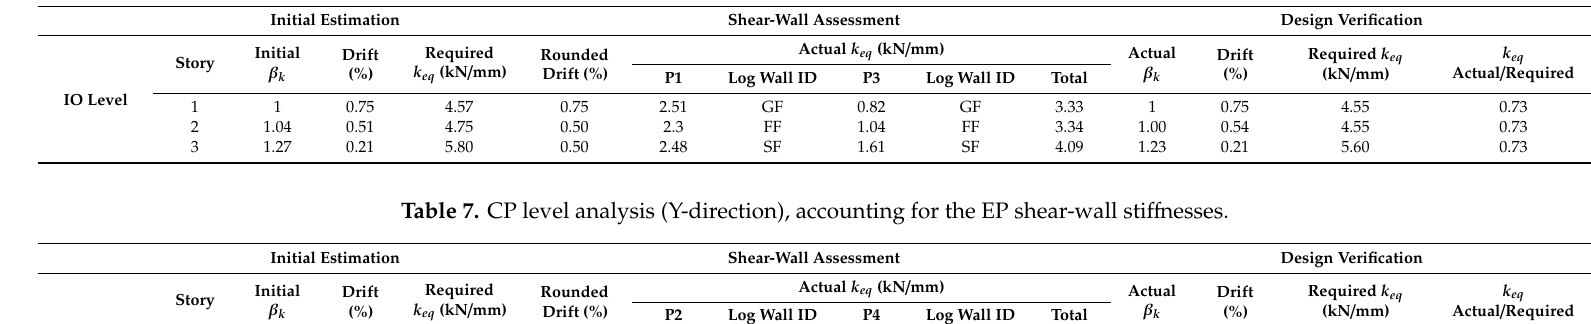
Table 6. Immediate Occupancy (IO) level analysis (X-direction), accounting for the EP shear-wall sti ff nesses.